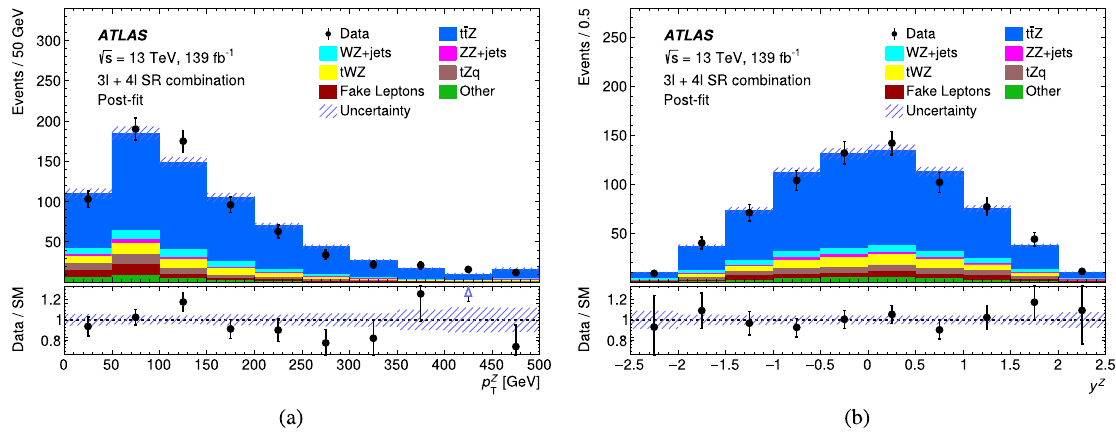
Fig. 6 Post-fit distributions of the a p T and b rapidity of the Z boson in the combination of the trilepton and tetralepton regions. The shaded band includes all sources of statistical and systematic uncertainty after the combined fit. The lower panel shows the ratio of data to the total